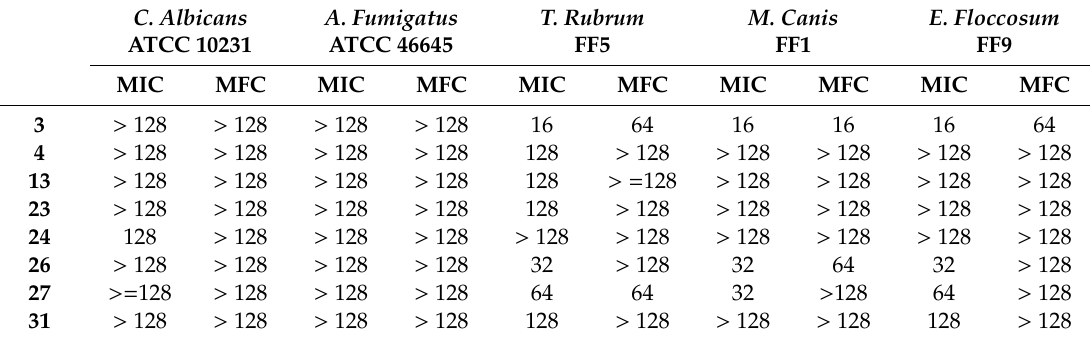
Table 4. Antifungal activity of the compounds 3 , 4 , 13 , 23 , 24 , 26 , 27 , and 31 . MIC and MFC are expressed in µg/mL.